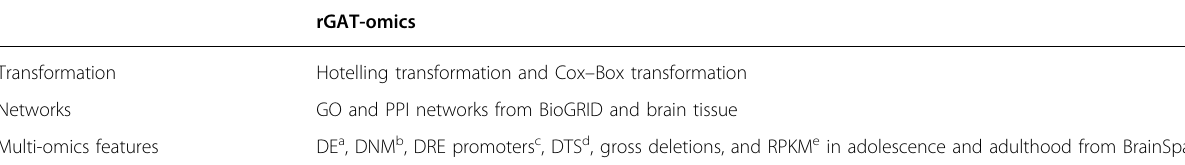
Table 1 Transformation approaches, networks, and multi-omics features used by rGAT-omics.